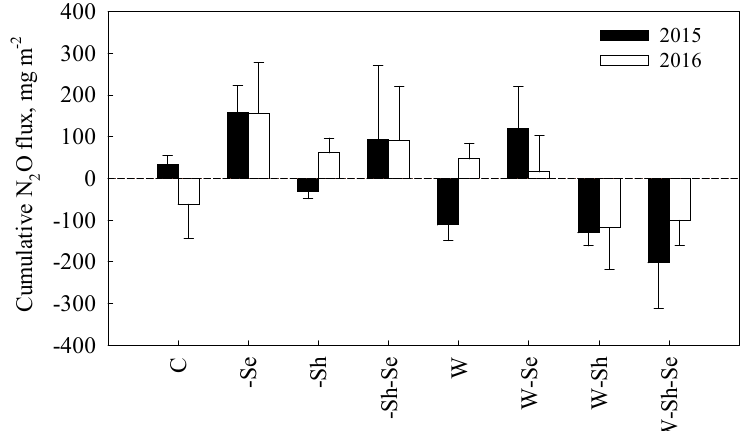
Figure 4. Cumulative N 2 O flux under different treatment during two growing seasons in 2015 and 2016. Error bar represents standard error ( n = 4).